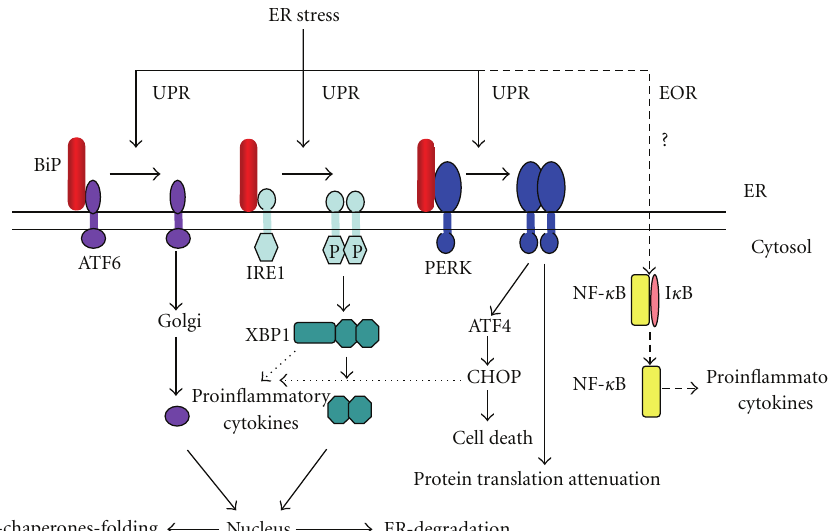
Figure 1: Schematic illustrating the basic outline of the ER stress pathways. The e ff ector molecules of the UPR, the transcription factor ATF6, and the kinases IRE1 and PERK are held in an inactive state via their association with the ER chaperone BiP. On sensing misfolding, BiP dissociates from these e ff ector molecules. This results in ATF6 tra ffi cking to the Golgi where two Golgi resident proteases cleave the ATF6 cytosolic domain which acts as a transcription factor activating folding chaperones. IRE1 oligomerises and autophosphorylates, which can splice the 26-base pair intronic sequence from XBP1 mRNA, which is then religated and encodes for a potent transcription factor. XBP1 induces the production of chaperones and proteins involved in protein folding or degradation. PERK oligomerises and autophosphorylates which in turn phosphorylates the elongation factor 2 α that inhibits protein translation. PERK can activate ATF4 and CHOP which can activate apoptosis. Since being reported, little is known about the EOR, which is thought to detect a build-up of proteins within the ER and activate NF- κ B, which can target proinflammatory cytokine